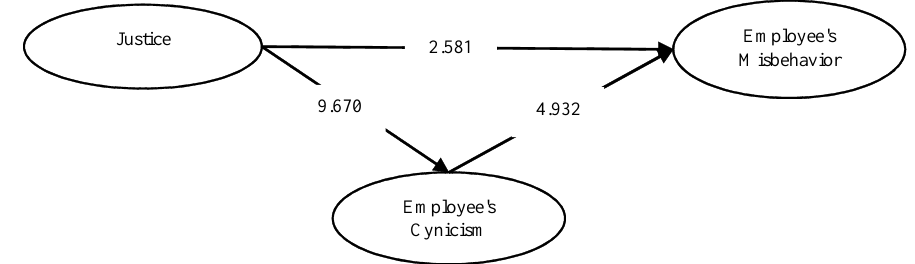
Fig. 2: T-value for estimate path coefficient meaningful in